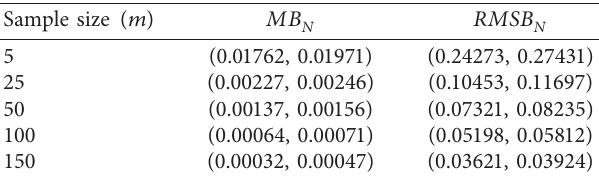
Table 1: Performance of the ML estimator of NMD for simulated